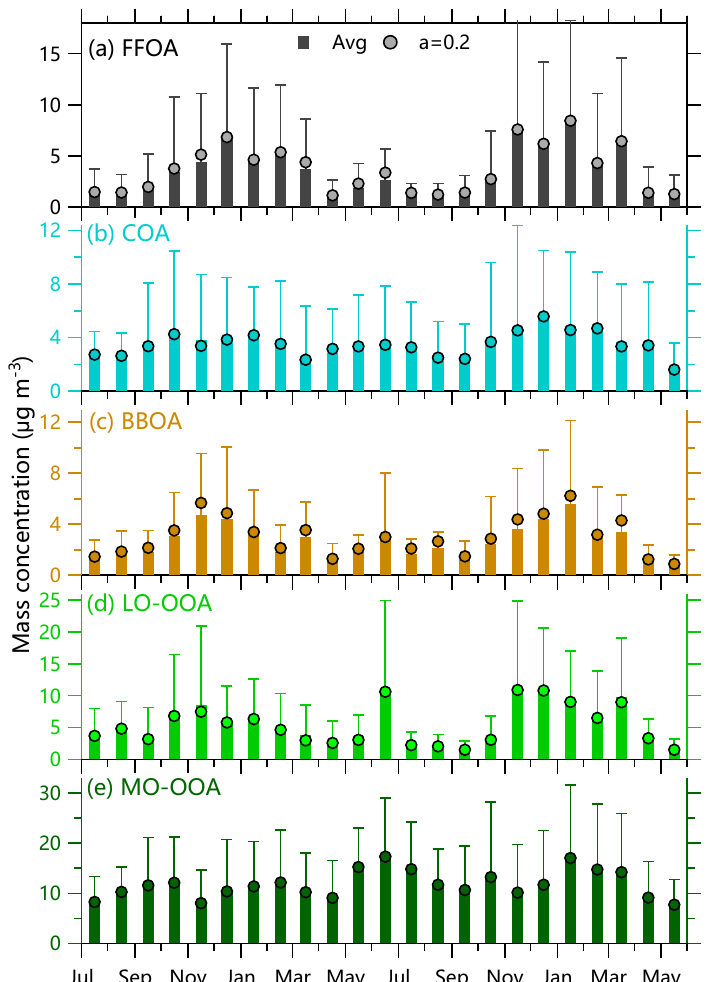
Figure 4. Monthly average mass concentrations of five OA factors. The bars are the average of ME-2 results from three model runs, i.e., a = 0, 0.1, and 0.2. The results with a = 0.2 are also shown for a comparison. The error bars represent 1 standard deviations of monthly